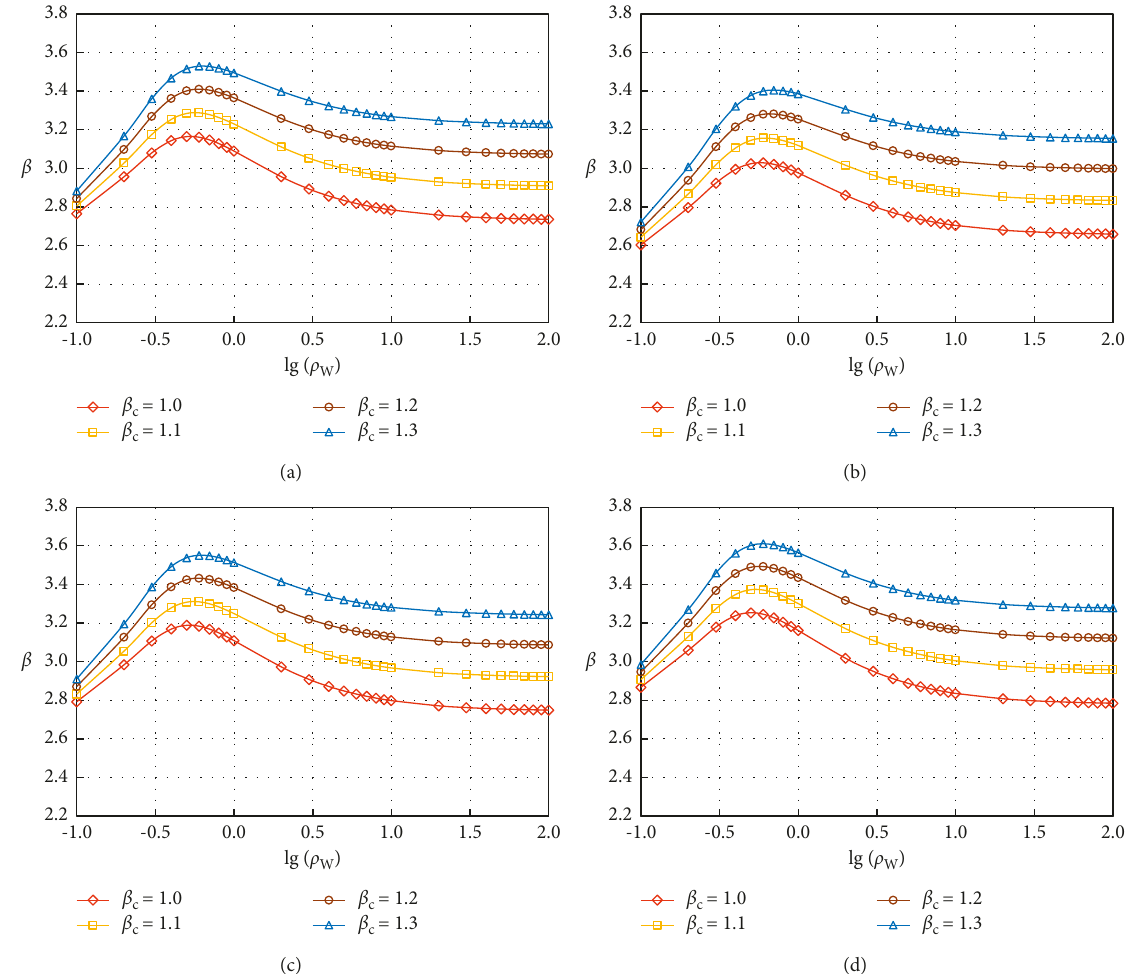
Figure 2: Reliability indices for strength calculation of axially loaded member. (a) Q235: d > 16 ∼ 40 mm, (b) Q235: d > 40 ∼ 60 mm, (c) Q345: d > 16 ∼ 35 mm, and (d) Q345: d > 35 ∼ 50